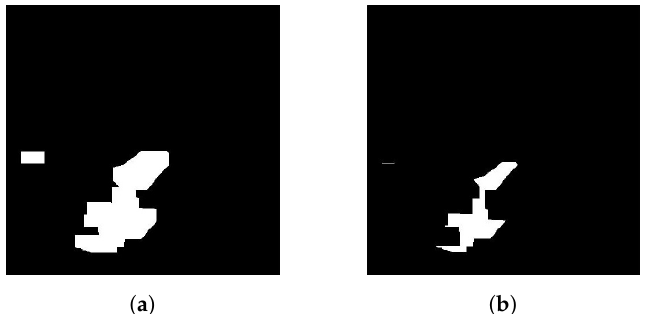
Figure 20. Example of adjustment of objects found in the binary image by dilatation and reverse erosion of objects by a rectangular area of 20 × 20 pixels, both in the horizontal and vertical directions. ( a ) The result of the filtered finding dilatation. ( b ) The result of the reverse erosion of the binary image ( a